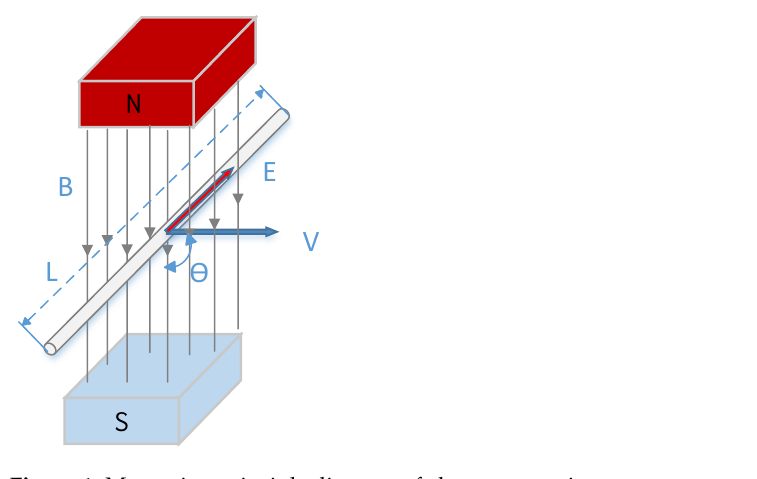
Figure 1. Measuring principle diagram of electromagnetic current meters.